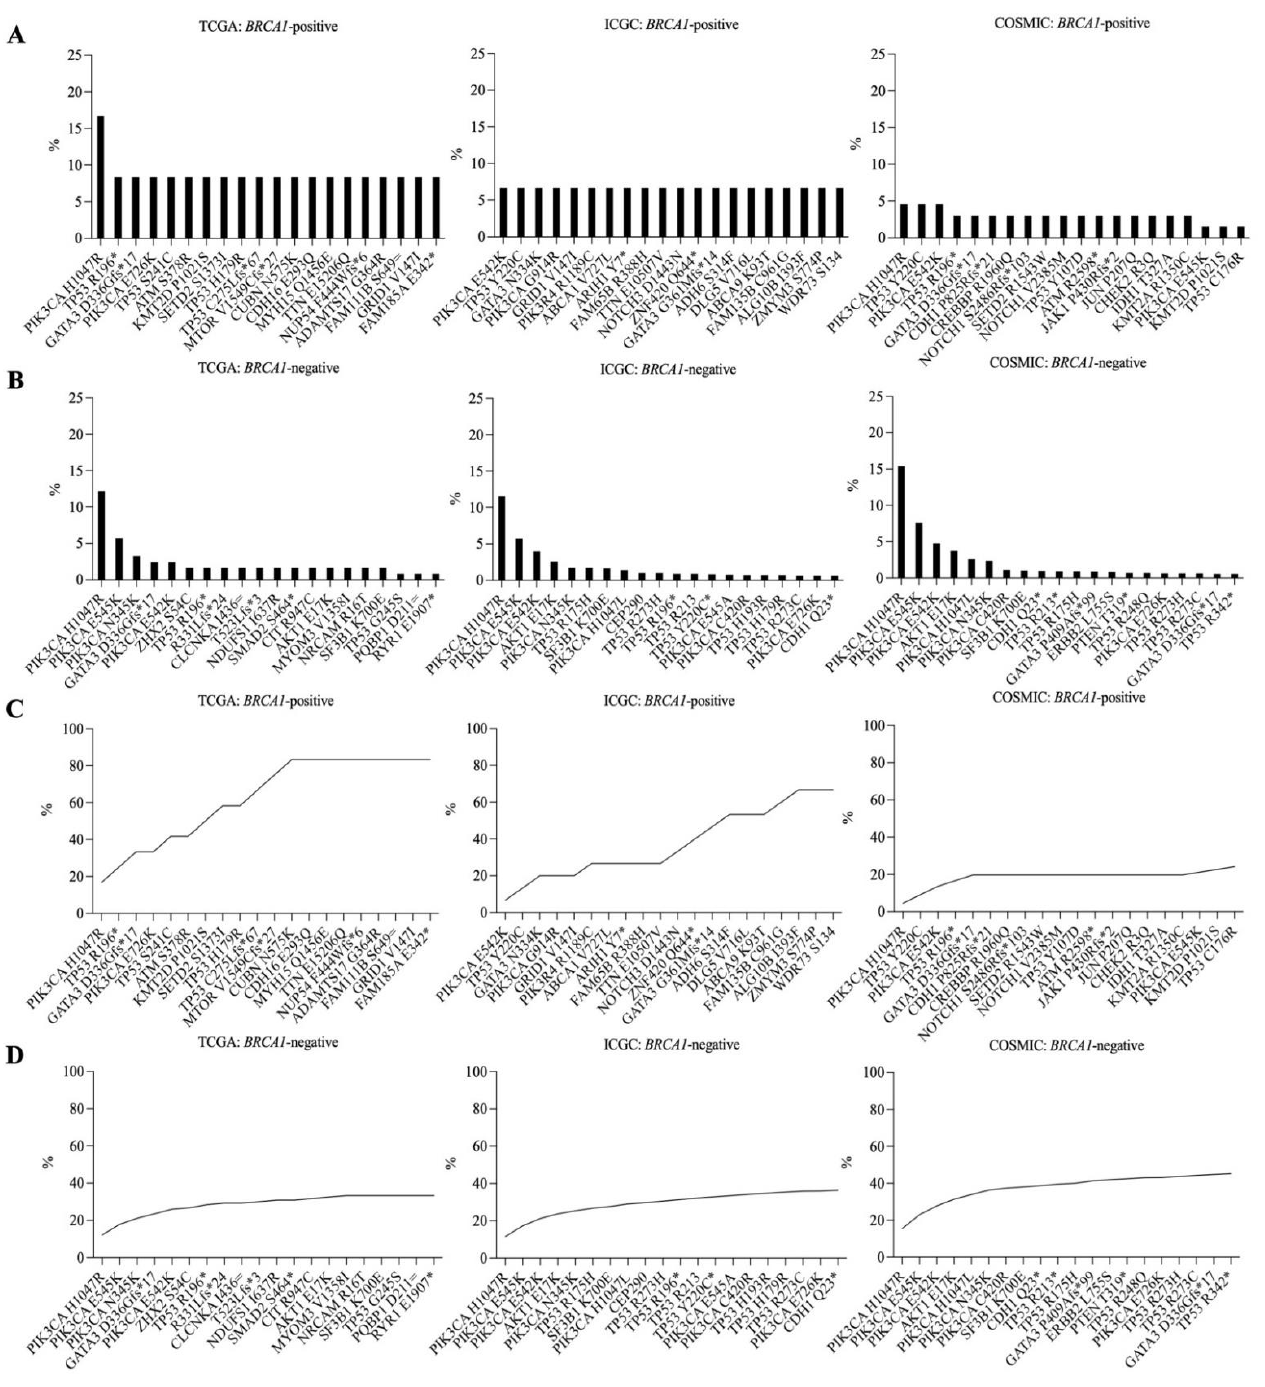
Figure 6. Top recurrent somatic mutations of ( A ) BRCA1 -positive, and ( B ) BRCA1 -negative samples. Cumulative coverage of recurrent mutations in ( C ) BRCA1 -positive and ( D ) BRCA1 -negative samples. X-axes indicate coding-region somatic mutations and the Y-axes indicate the percentage of all samples with the corresponding mutation. (* indicates stop gained variants)